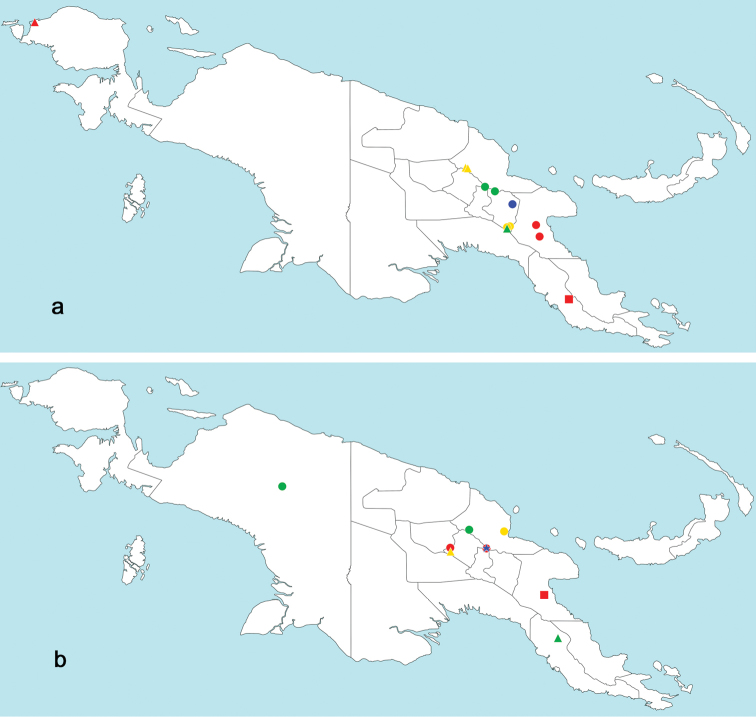
Distribution of Labiobaetis in New Guinea: a red circle, L.tuberpalpus; yellow circle, L.branchiaesetis sp. n.; green circle, L.magnovaldus sp. n.; red triangle, L.planus sp. n.; blue circle, L.podolakae sp. n.; yellow triangle, L.rutschmannae sp. n.; green triangle, L.schwanderae sp. n.; red square, L.centralensis sp. n. b yellow circle, L.paravitilis sp. n.; red circle, L.altus sp. n.; green circle, L.gindroi sp. n.; yellow triangle, L.vitilis; green triangle, L.pindaundensis sp. n.; red square, L.xeniolus; blue star, L.wilhelmemsis sp. n. / L.dendrisetis sp. n. / L.pindaundensis sp. n.